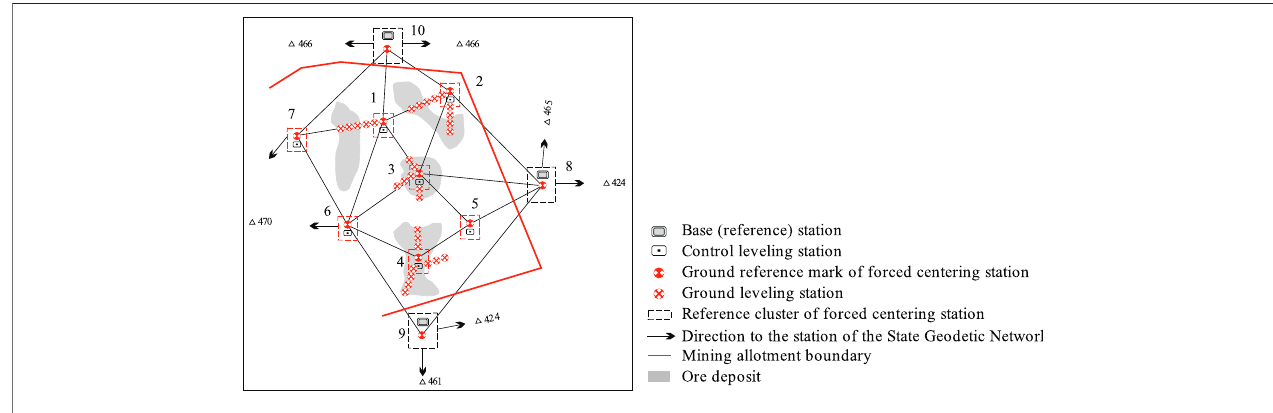
FIGURE 8 | Scheme of the observational network at the geodynamic test.